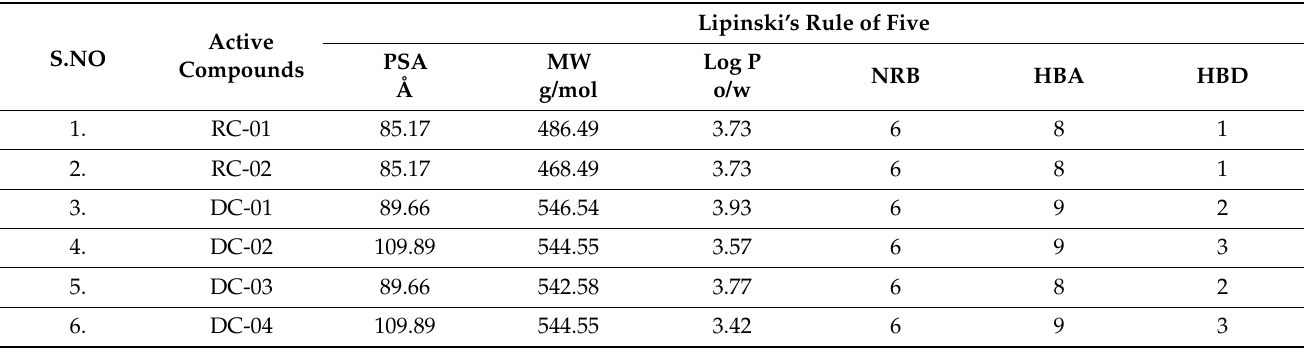
Table 4. ADME properties of the designed drugs along with reference